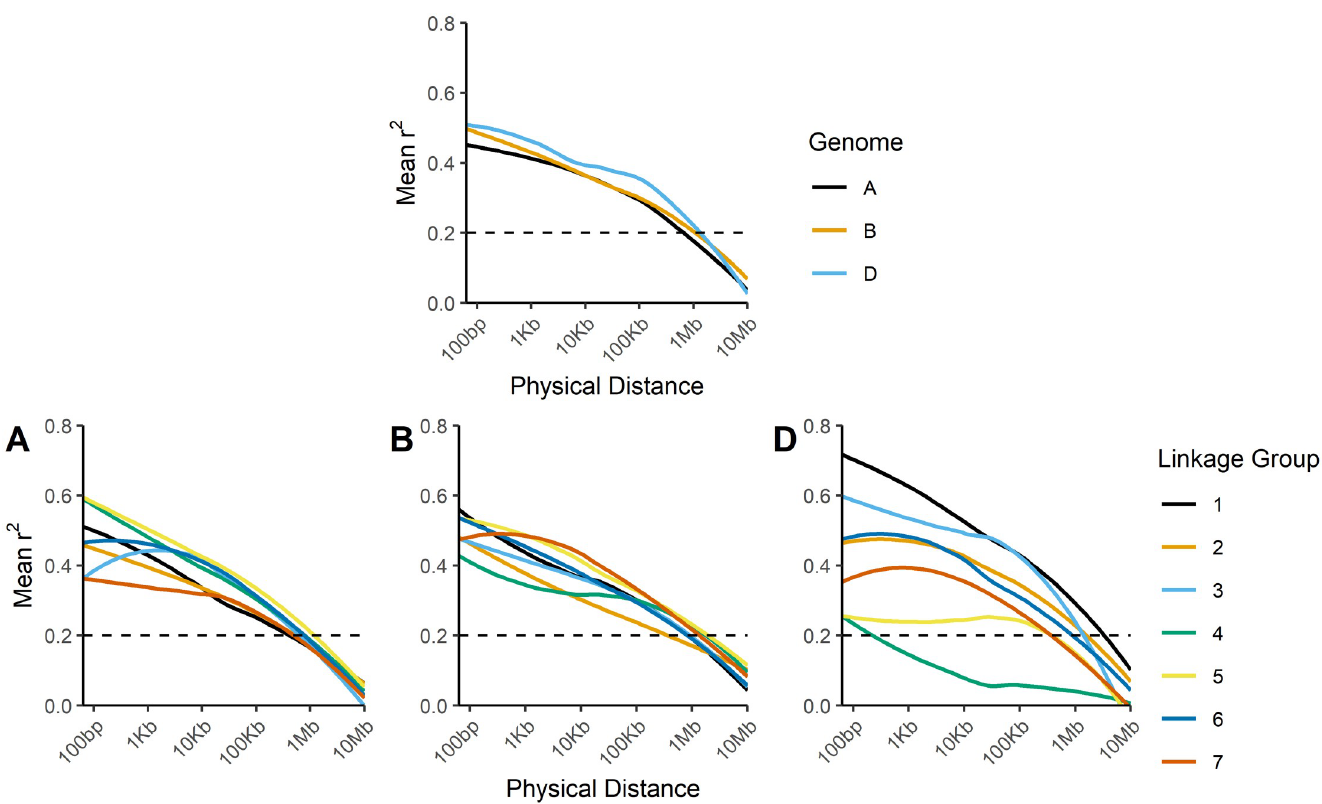
Fig 2. Linkage disequilibrium by genome and chromosome. LOESS regressions of mean r 2 between pairs of SNPs vs. physical distance, pooled for each genome (top row), and for each of the seven chromosomes present in the A, B, and D genomes (bottom